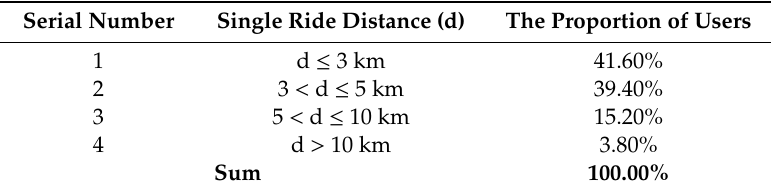
Table 1. Bike-sharing user single ride distance